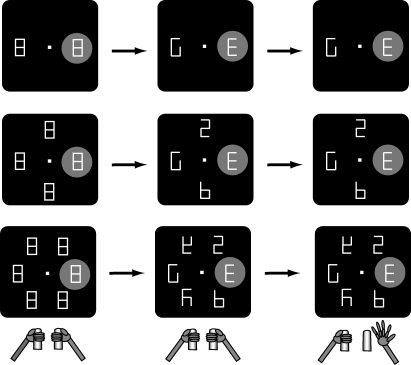
The Covert Search TaskThe task was run in randomly interleaved trial blocks with set sizes of 2, 4, or 6 elements (top, middle, and bottom rows). A circular array with the appropriate number of figure-8 placeholders remained on the screen in the intertrial interval. To initiate each trial monkeys fixated a central fixation point and grasped two response bars positioned at waist level, outside their field of view (left panels). During central fixation, one placeholder fell in the center of the neuron's RF (gray patch). After a 500 ms presearch period, two line segments were removed from each placeholder, revealing several distractors and one target, an E-like shape (middle panels). Monkeys were rewarded for maintaining fixation and reporting the orientation of the target by releasing the right bar if the “E” was right-facing (right panels) or the left bar if it was left-facing.